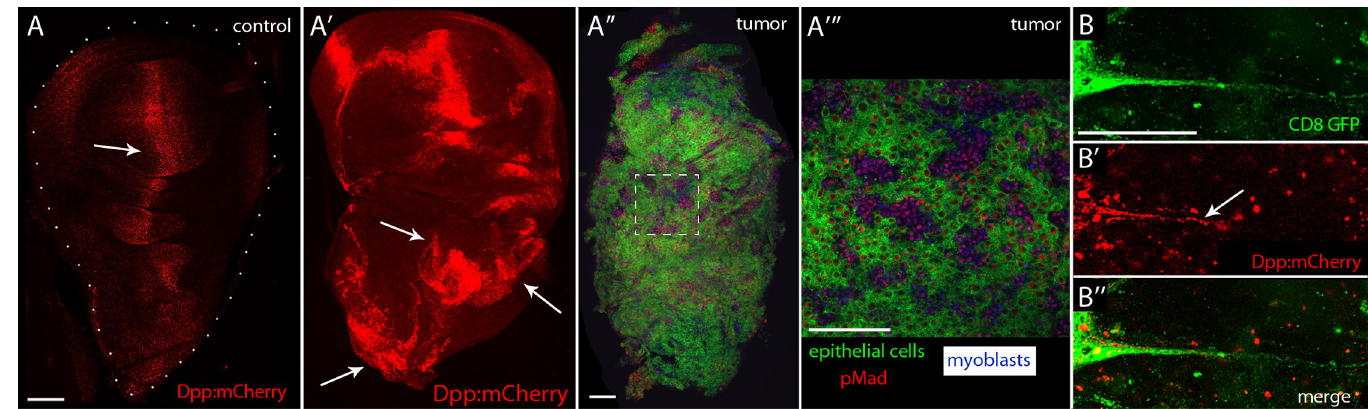
Fig 2. Dpp signaling in the EGFR-Pcn tumor model. (A,A’,B) Unfixed wing discs showing the Dpp distribution. (A) Control disc with Dpp (red, arrow). Genotype: Dpp : mCherry . Scale bar: 100 μ m. (A’) Disc with EGFR-Pcn tumor induced for 5 days expressing Dpp (red) in tumor cells. Genotype: ap-Gal4 , UAS-psq RNAi /Dpp : mCherry; UAS-EGFR , tub-Gal80 ts /UAS-CD8 : GFP . Arrows indicate Dpp up-regulation. (A”-A”’) EGFR-Pcn wing showing epithelial tumor cells (green) fixed and stained with α - phosphorylated MAD (pMad, red) antibody to monitor Dpp signaling and α -Cut (blue) to label myoblasts. Genotype: ap-Gal4 , UAS-psq